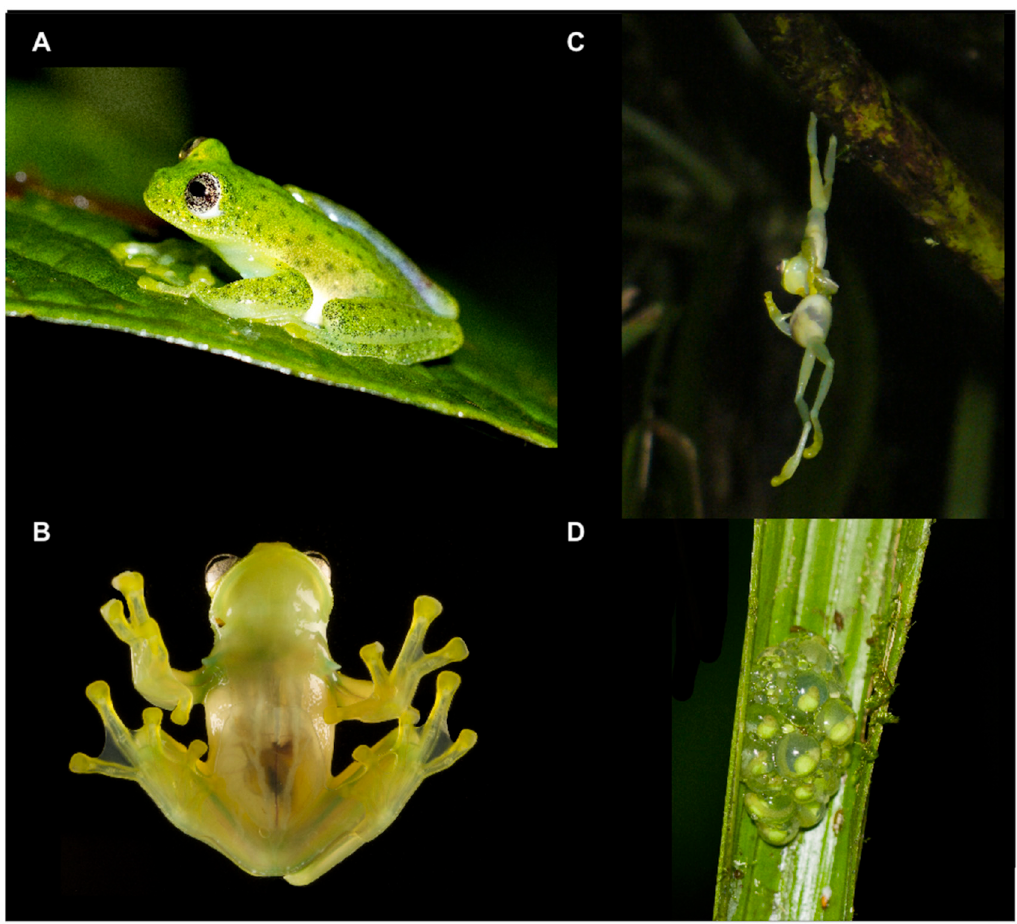
Figure 43. Centrolene lynchi in life from Reserva Las Gralarias, Pichincha province, Ecuador. ( A ) Adult male, not collected. ( B ) Adult male in ventral view, QCAZ 40192; photo by Luis A. Coloma. ( C ) Fight between males; photo by Henry Imba and Rebecca Abuza. ( D ) Egg clutch.